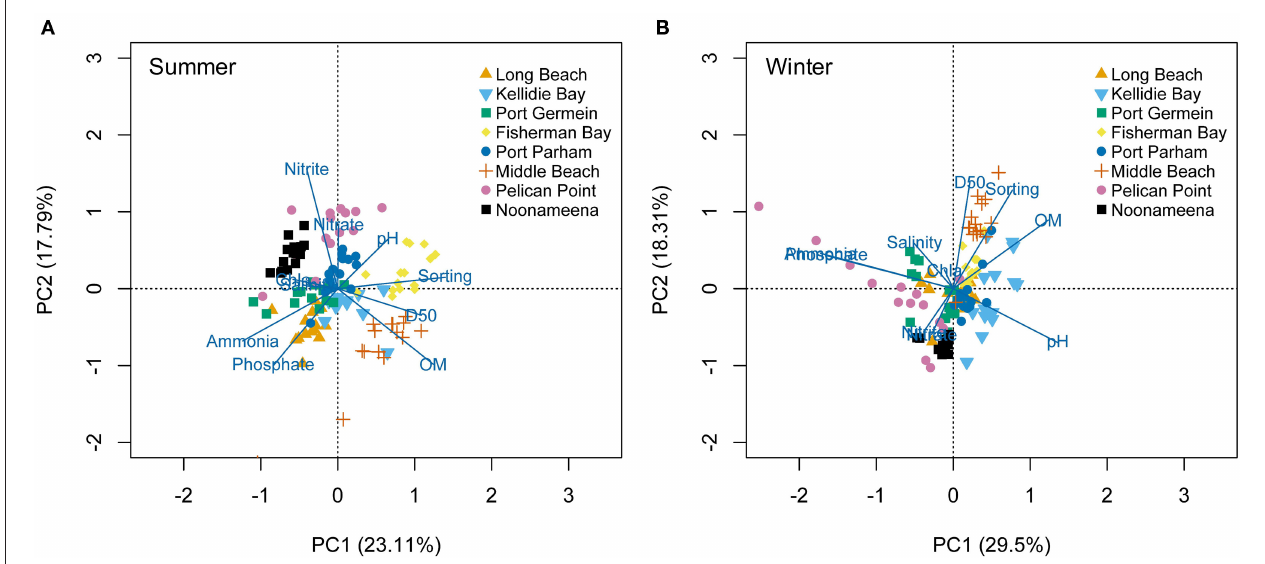
FIGURE 2 | Principal Component Analysis (PCA) on the environmental conditions measured at the eight sites across South Australia, in the seasons: (A) Summer, and (B) Winter.